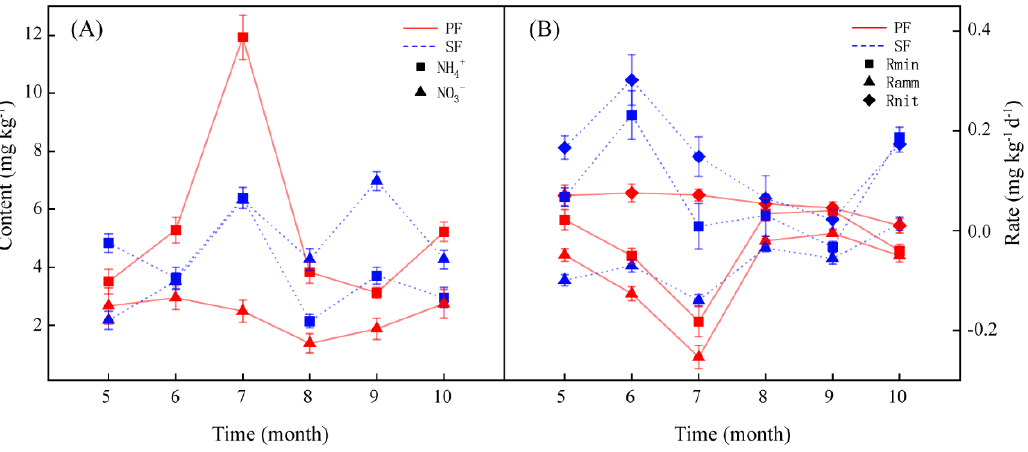
Figure 2. Dynamics of soil NH 4 + and NO 3 − content ( A ), and N transformation rates ( B ) from May to October in the two forest types. Red and blue represent the primary Korean pine forests (PF) and secondary broad-leaved forests (SF), respectively. R amm : Net ammonification rate. R nit : Net nitrification rate. R min : Net mineralization rate.